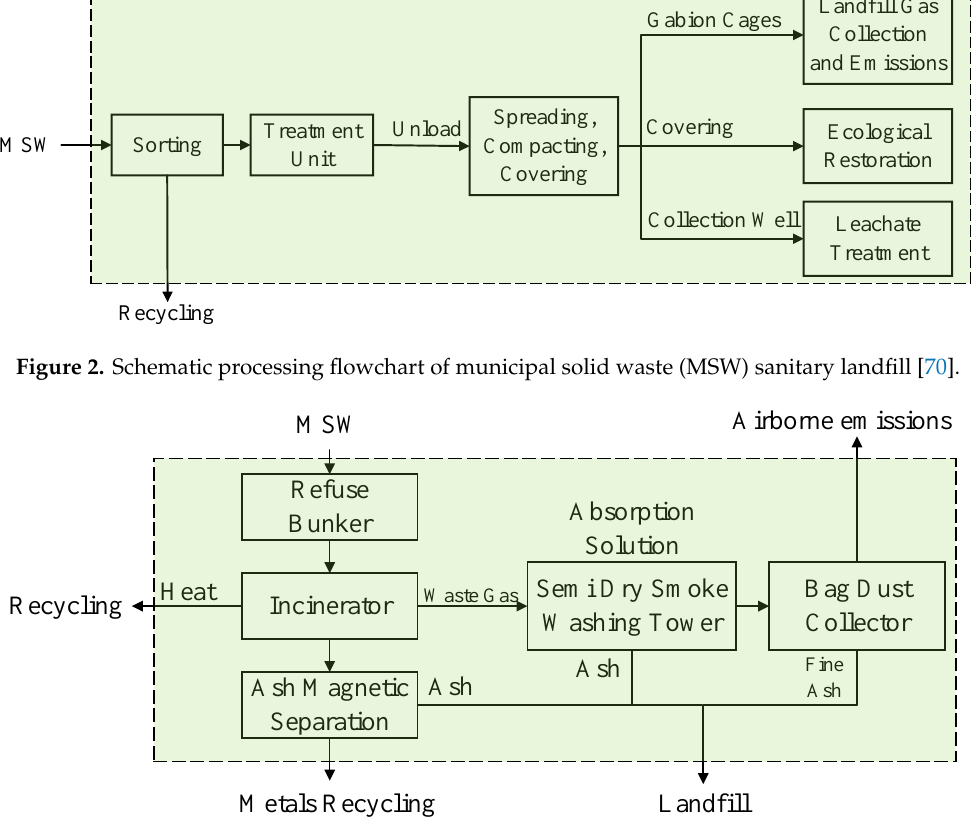
Figure 3. Schematic processing flowchart of municipal solid waste (MSW) incineration. [68].